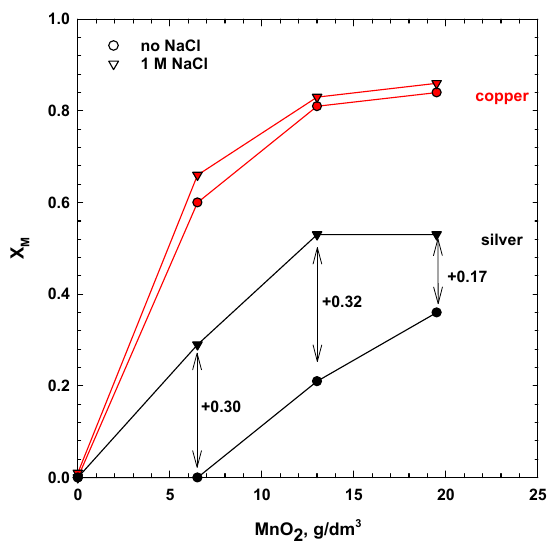
Figure 3. Effects of the addition of manganese dioxide and sodium chloride on the ultimate extraction of copper and silver (80 °C, 1 M H 2 SO 4 , 30 g/dm 3 SMS, 300 rpm, leaching time 24 h).